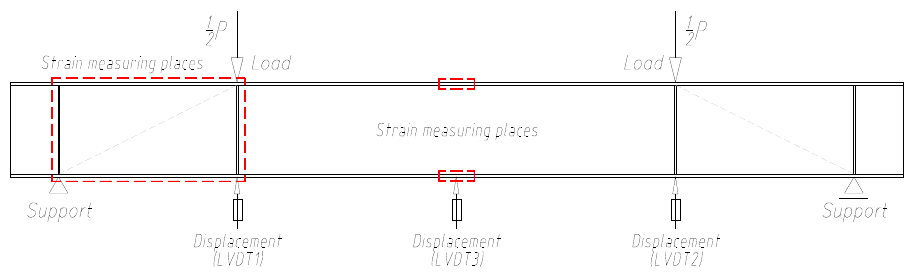
Figure 8. Distribution of displacement sensors and location of strain measurement sites on tested beams.